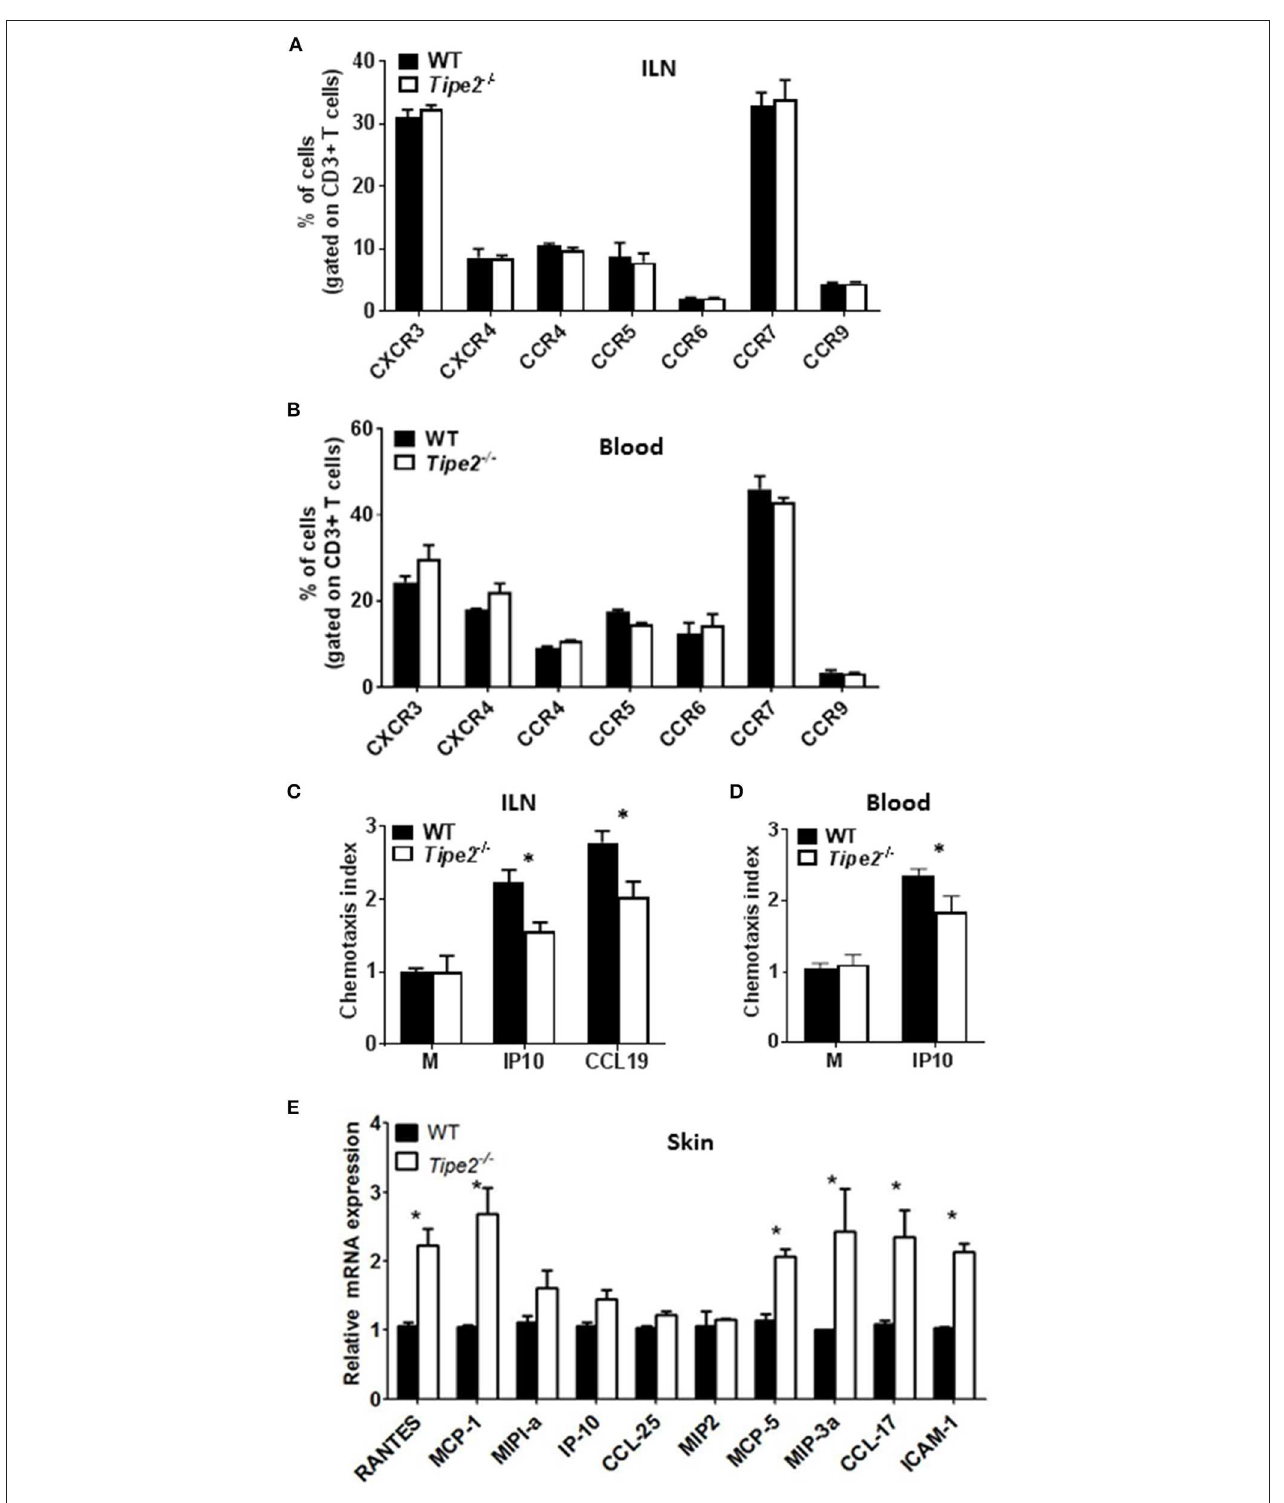
FIGURE 5 | T cells from TIPE2-deficient mice express normal levels of chemokine receptors but are defective in chemotaxis in vitro . WT ( n = 5) and TIPE2-deficient ( n = 5) mice were treated as in Figure 1A and killed 3 days after the first IMQ treatment. (A) Total cells were isolated from ILN and the expression of indicated chemokine receptors on the surface of CD3 + T cells was determined by cell surface staining with florescence-labeled antibodies against CD3 and chemokine receptors. Data